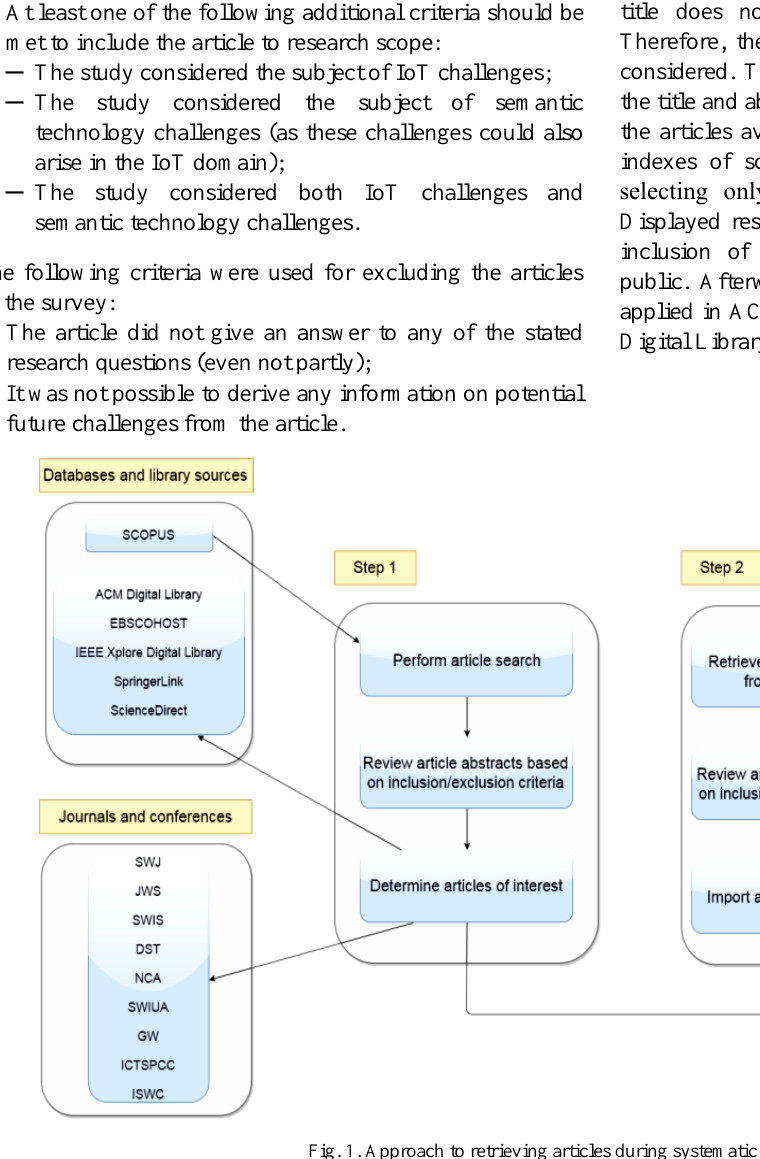
Fig. 1. Approach to retrieving articles during systematic literature